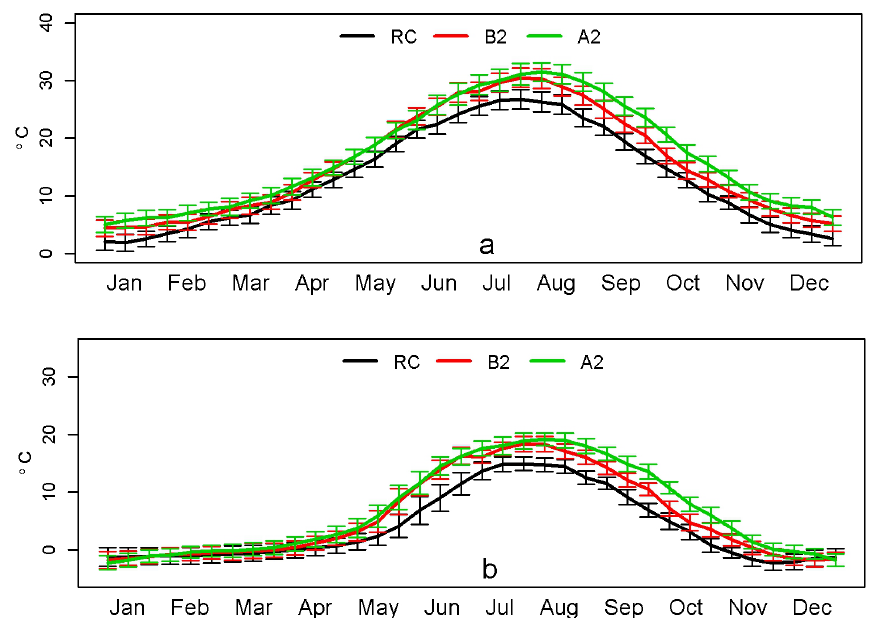
Figure 4. Annual cycles of the 10-day average soil temperatures (in ◦ C) in the upper soil layer (5 cm deep) in the RC (black), FC B 2 (red) and FC A 2 (green) at ( a ) plains and ( b ) high mountains. The standard deviations are also plotted (vertical